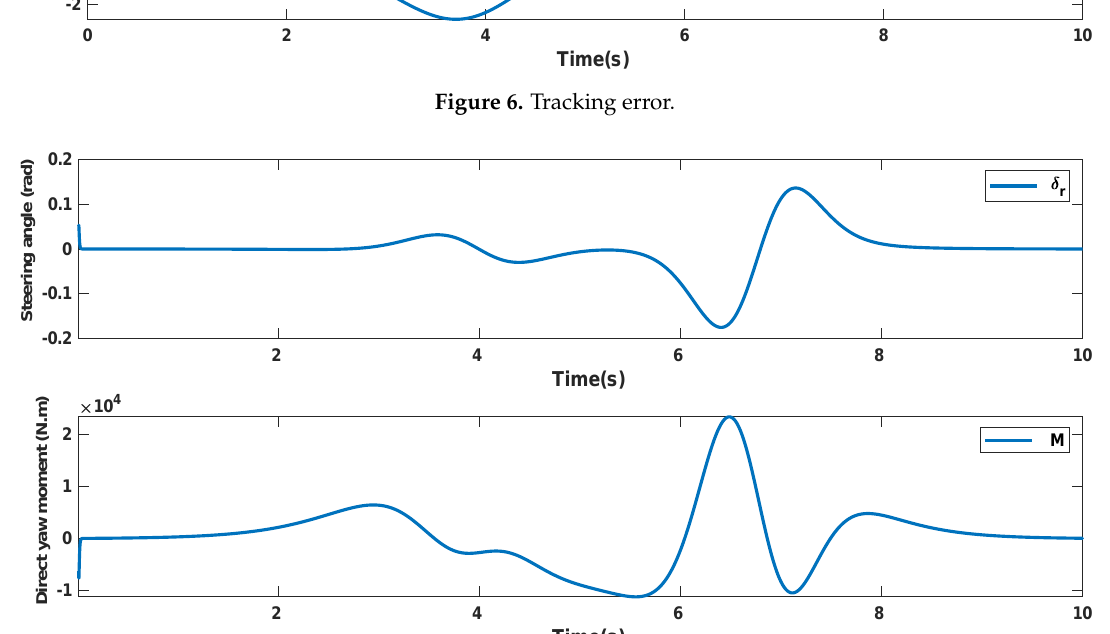
Figure 6. Tracking error.